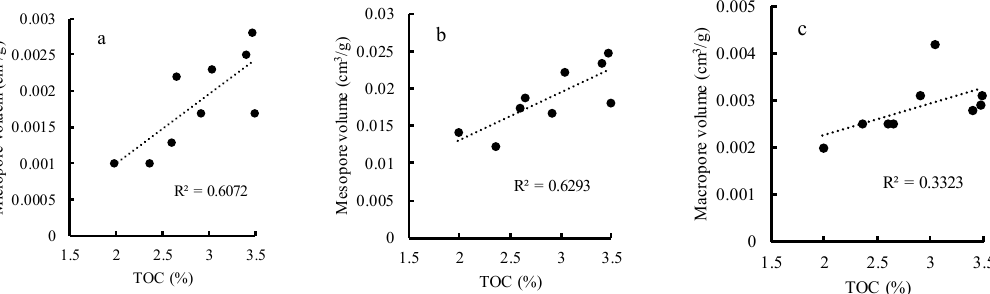
Figure 3. ( a ) The relationship between Micropore volume and TOC. ( b ) The relationship between Mesopore volume and TOC. ( c ) The relationship between Macropore volume and TOC.